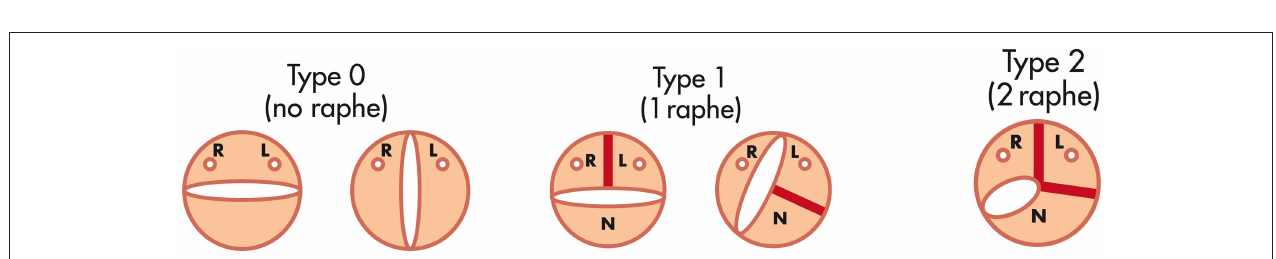
FIGURE 2 | The Sievers and Schmidtke classification system for bicuspid aortic valve [Adapted from Sievers et al. (33)].